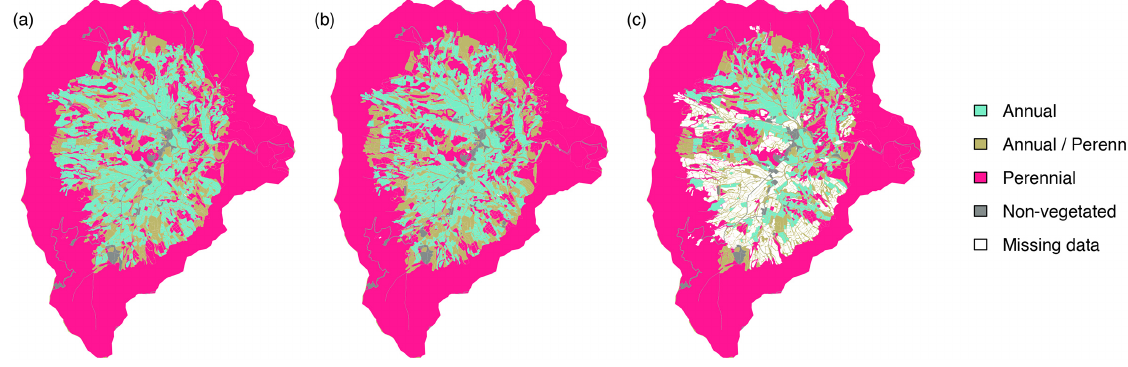
Figure 3. Life cycle of the vegetation cover according to the FAO-LCCS in (a) 2009, (b) 2010 and (c) 2011.